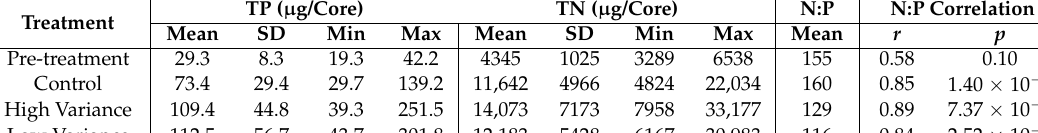
Table 2. Means and ranges of mat total phosphorus (TP), total nitrogen (TN), and N:P mass ratio. N:P correlations compared pre-treatment mats to experimentally treated mats after the final inundation period.